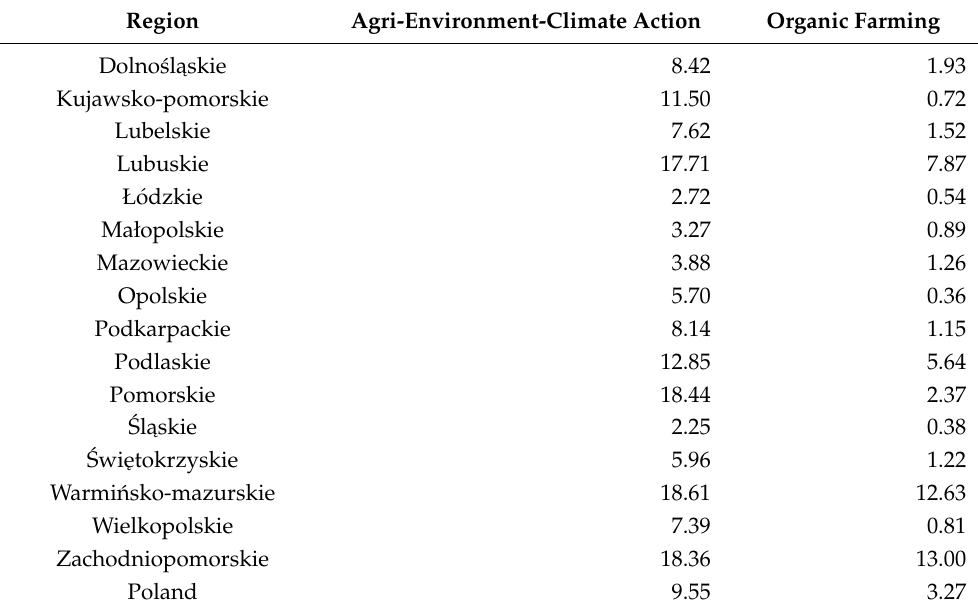
Table 2. Number of beneficiaries of agri-environmental, climate action, and organic farming in regions per 100 farms across Polish